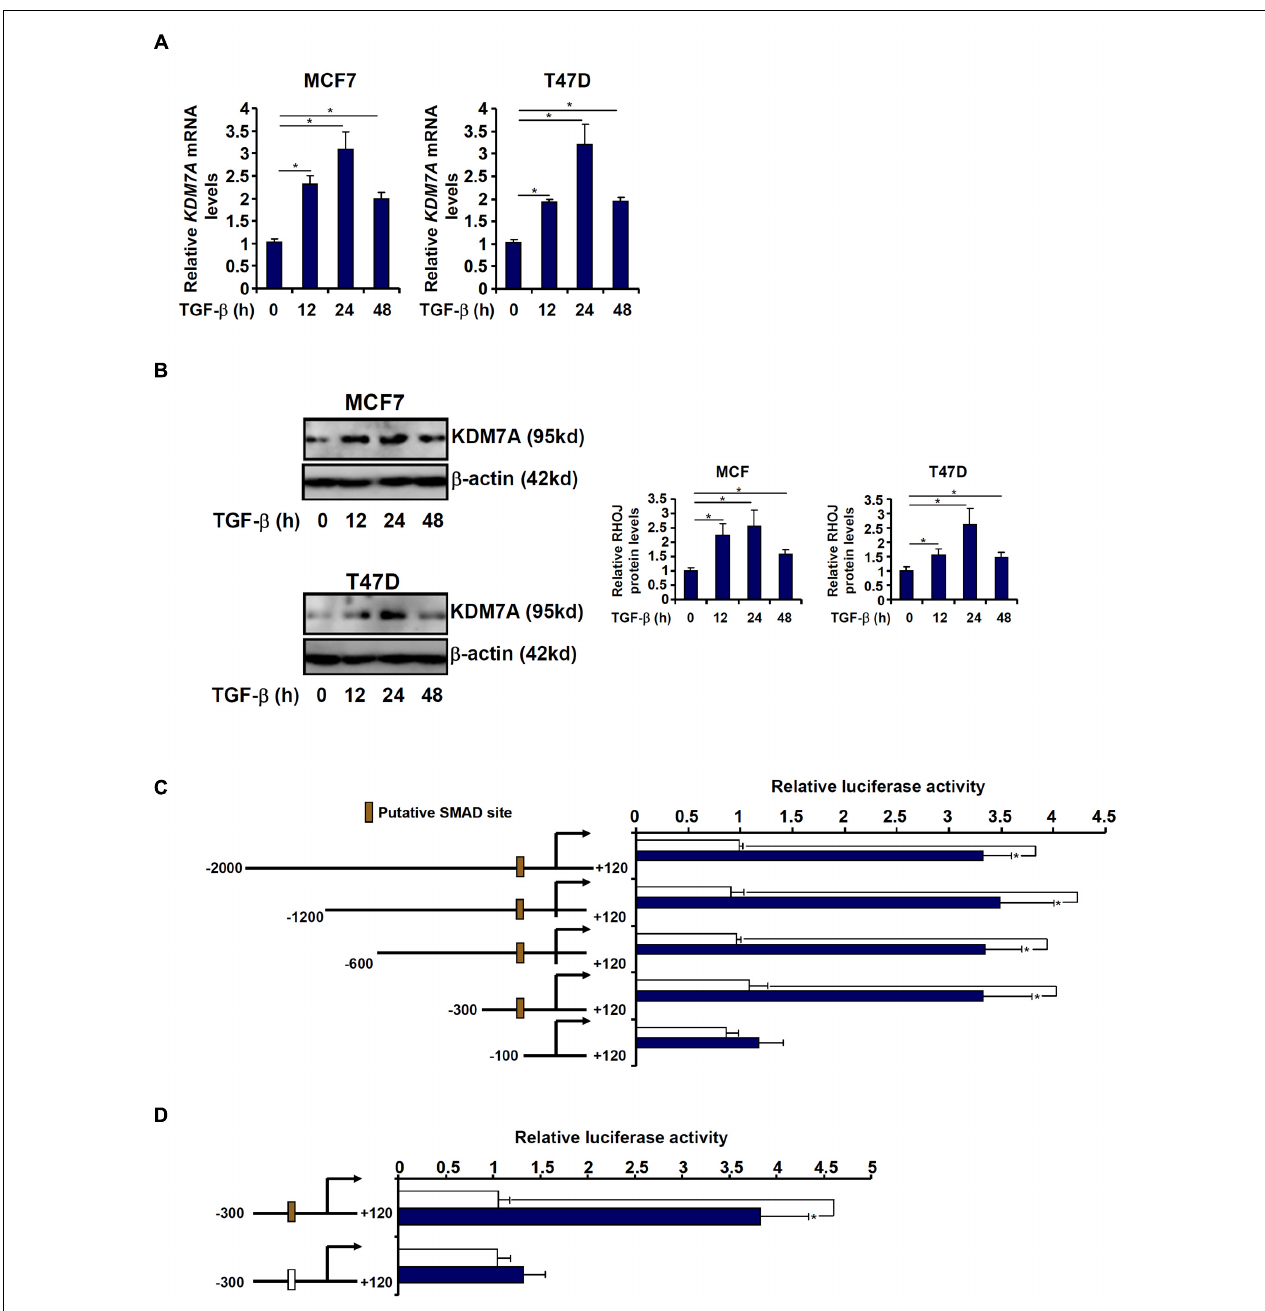
FIGURE 6 | JHDM1D/KDM7A is transcriptionally activated by TGF- β in breast cancer cells. (A,B) MCF7 (left panel) and T47D cells (left panel) were treated with TGF- β and harvested at indicated time points. KDM7A expression was examined by qPCR and Western blotting. (C) Human KDM7A promoter constructs were transfected into MCF7 cells followed by treatment with TGF- β . Luciferase activities were normalized by protein concentration and GFP fluorescence. Data are expressed relative luciferase activities compared with the control group. (D) Wild-type and mutant human KDM7A promoter constructs were transfected into MCF7 cells followed by treatment with TGF- β . Luciferase activities were normalized by protein concentration and GFP fluorescence. Data are expressed as relative luciferase activities compared with the control group. All experiments were performed in triplicate wells and repeated three times, and one representative experiment is shown. Data represent mean ± SD. * p < 0.05, two-tailed t